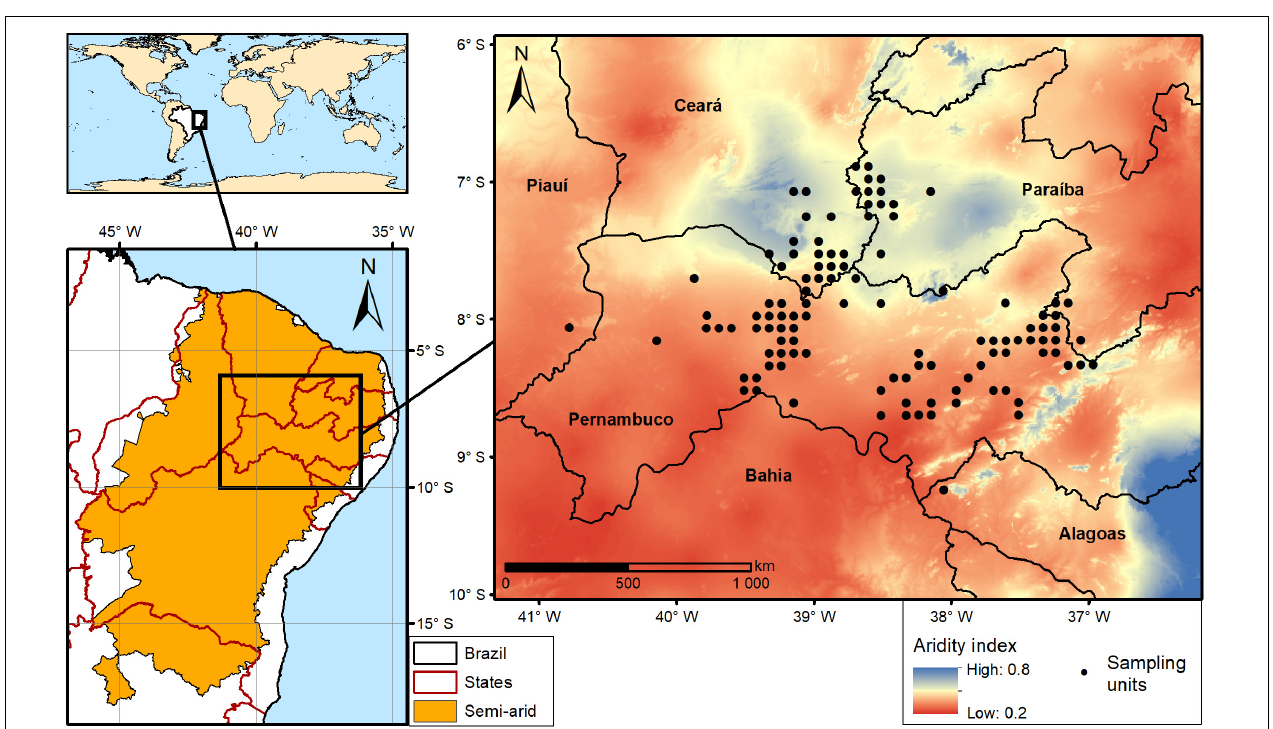
FIGURE 1 | Map with the location of the study area and the 113 sampling units (black dots) distributed along a regional aridity